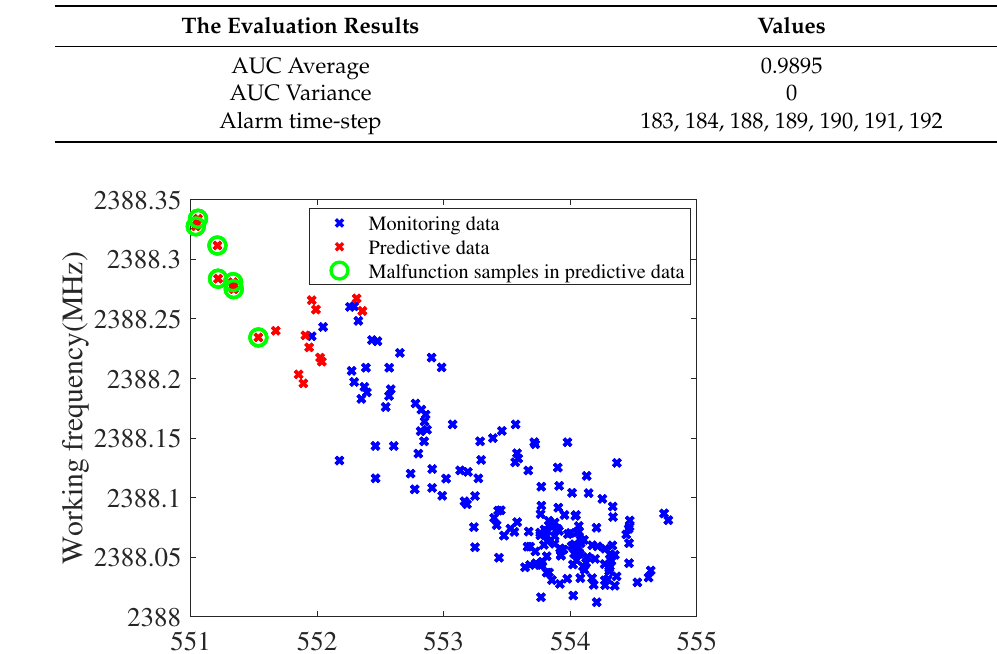
Table 3. M-iForest model evaluation results and malfunction alarm time-step of the first type of degradation malfunction.